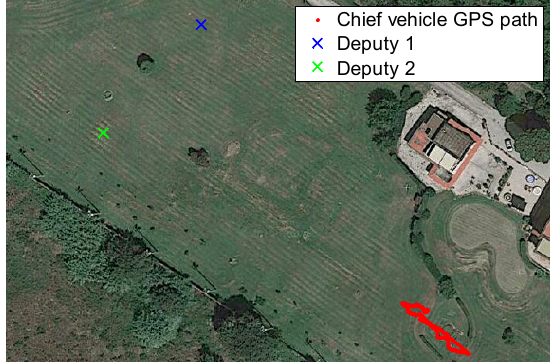
Figure 9. Formation geometry Test 1.